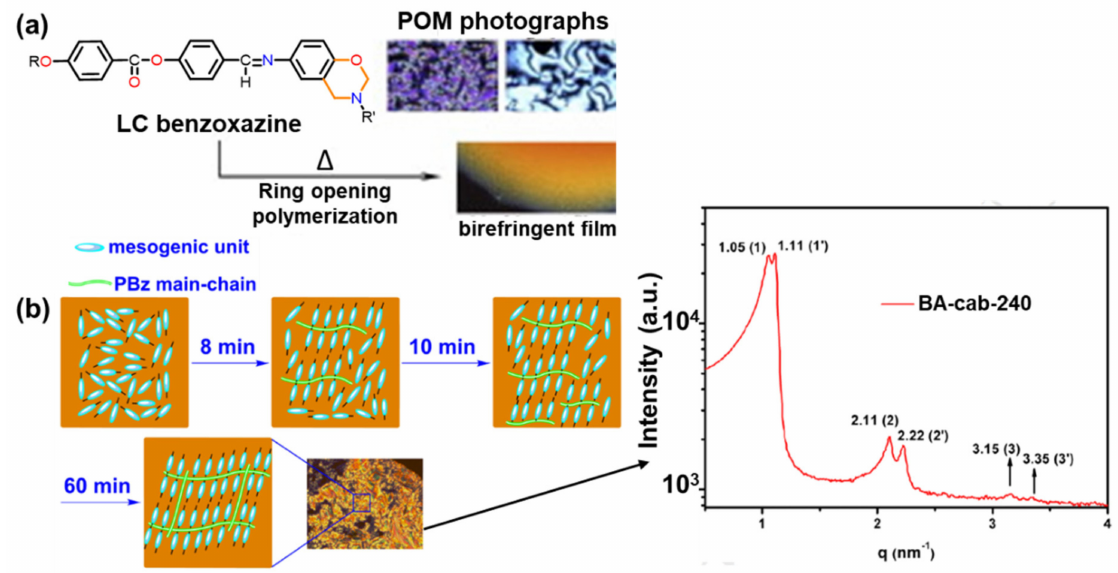
Figure 60. ( a ) A Schiff base based LC benzoxazine polymer with the corresponding POM image [382]. Copyright 2011. Reproduced with permission from Elsevier Ltd. ( b ) Development of liquid crystalline phases during isothermal curing and SAXS profile of BA-cab polymerized at 240 ◦ C [383]. Copyright 2018. Reproduced with permission from Elsevier